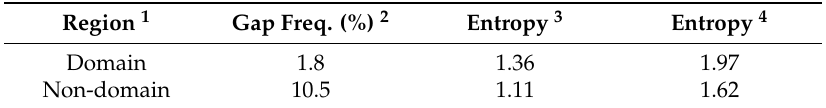
Table 2. Information per position of position-specific scoring matrices (PSSM) profiles in domain and non-domain